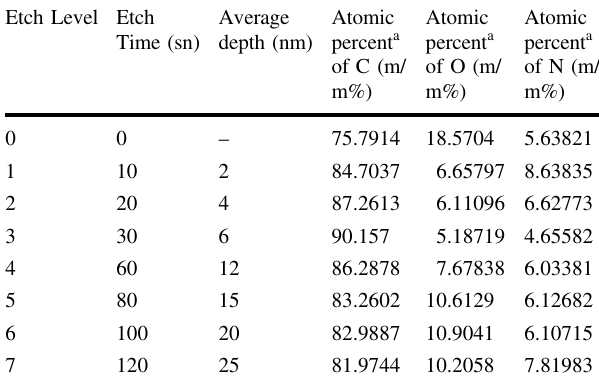
Table 2 Etching level, etch time, average depth and atomic ratios of C, O, and N elements at various etch levels from the